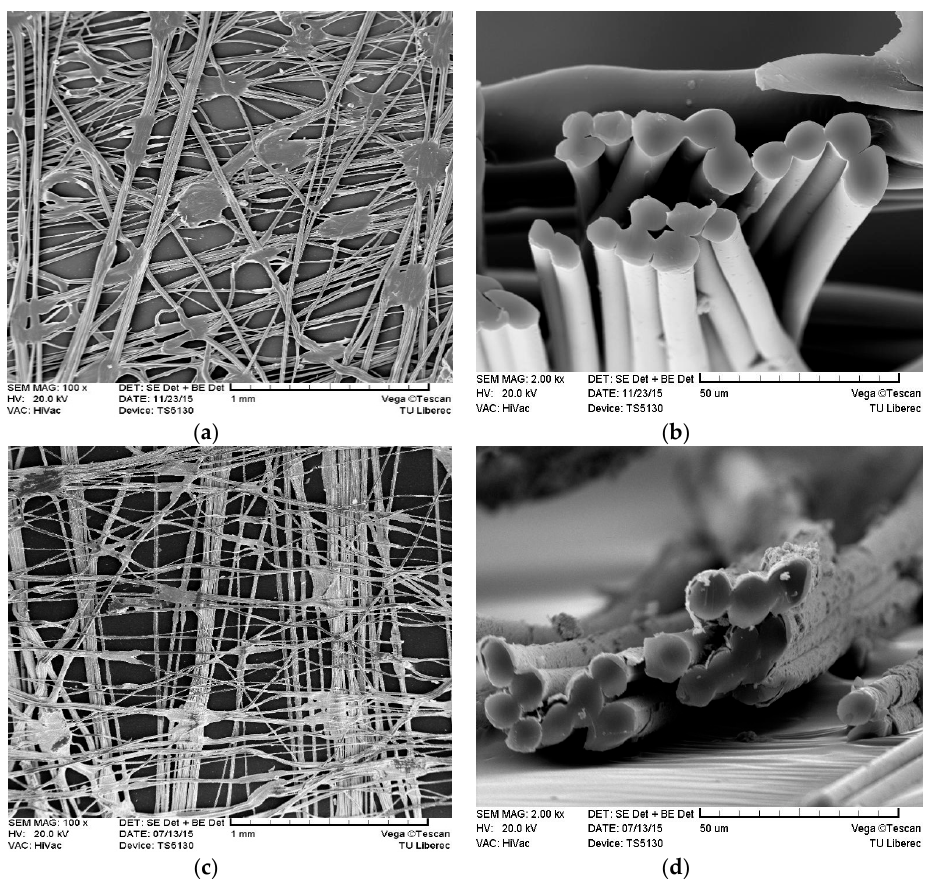
Figure 1. SEM image of the ultrathin nonwoven fabric ( a ) at 100× magnification, ( b ) cross-section view at 2000× magnification, SEM image of Cu/Ni coated ultrathin nonwoven fabric ( c ) at 100× magnification, ( d ) cross-section view at 2000× magnification.